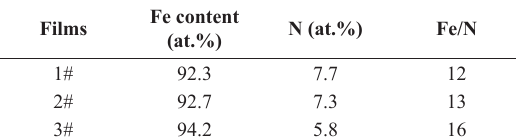
Table 1. Chemical compositions of the iron nitride films (measured by EDS).